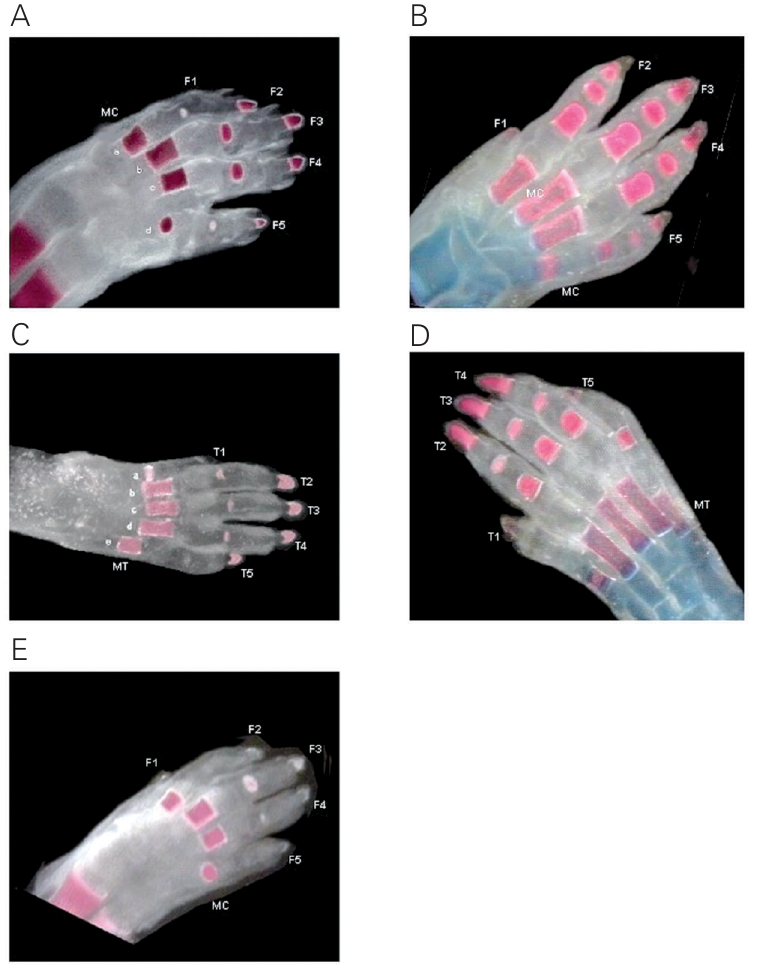
Figure 3. Extent of ossification of fore- and hindpaw bones in the rat on pregnancy day 21 and postnatal day 7. Panels A and D show the forepaws and panel C shows the hindpaws of pregnancy day-21 fetuses cleared and stained with alizarin red S. Panels B (forepaw) and E (hindpaw) show 7-day-old pups cleared and stained with alizarin red S (red color: calcified bones) and Alcian blue (blue color: cartilages). MC = metacarpus, MT = metatarsus, fingers (F1-F5), and toes (T1-T5) were numbered from the medial